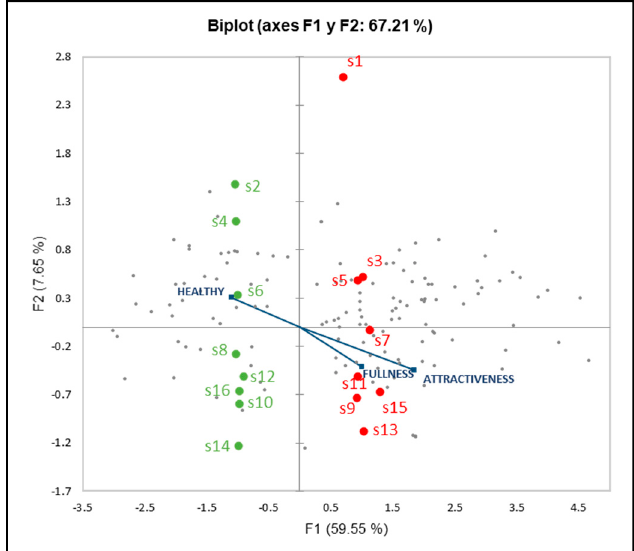
Figure 1. Consumer internal preference map obtained from acceptance ratings and projection of fullness, healthy, and attractiveness as supplementary variables.